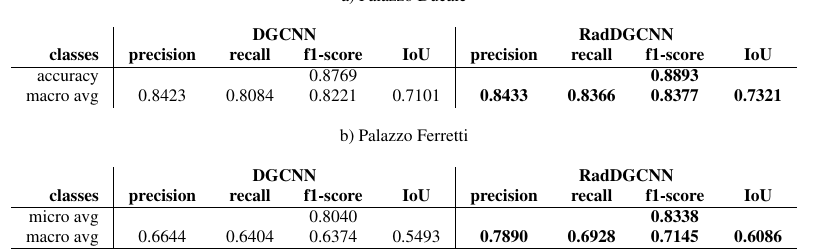
Table 5. Example of results with different values of K and R (K=40, R=0.2), for the two scenes (Ducal Palace, a), and Palazzo Ferretti,